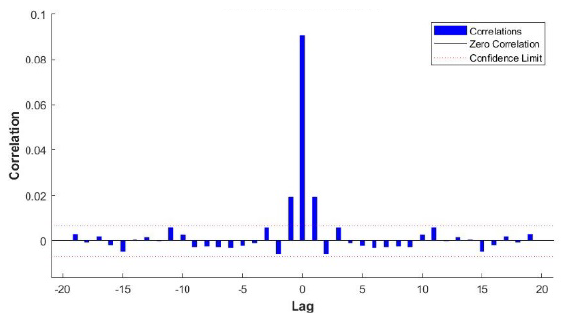
Figure 9. Error correlation, Case 1.